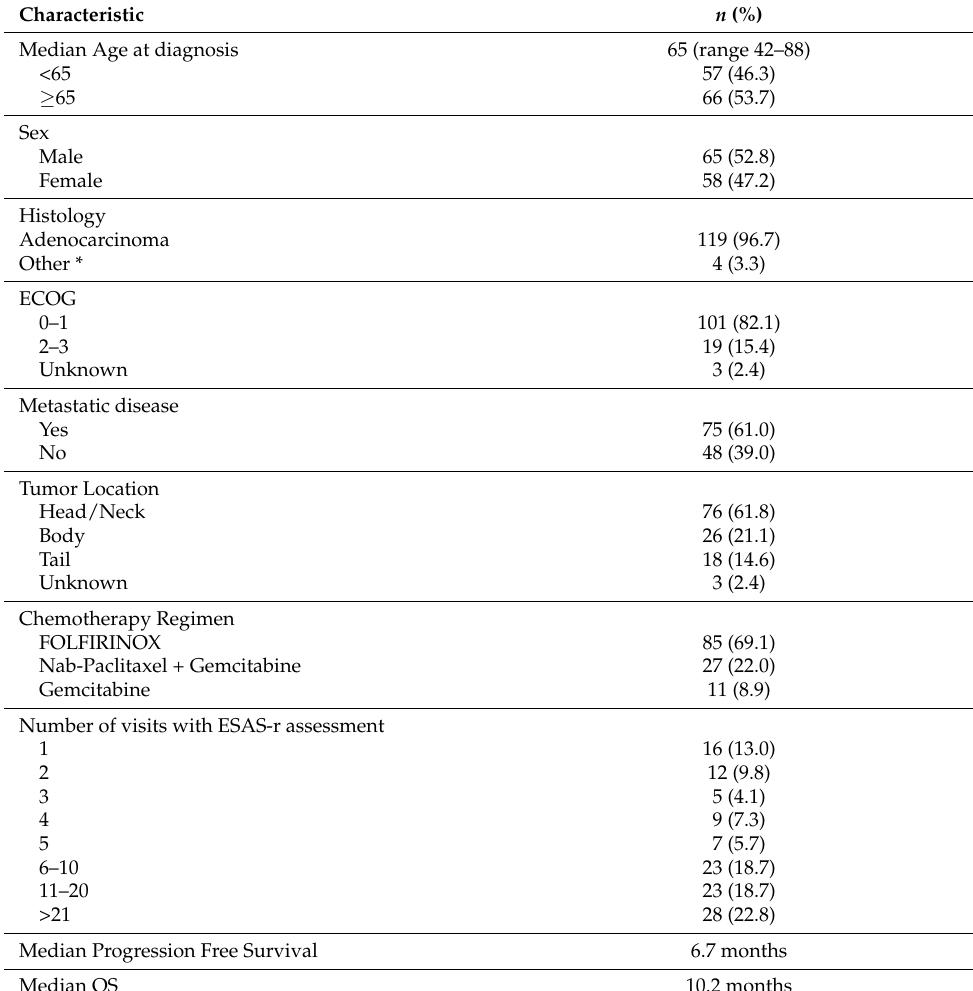
Table 1. Baseline characteristics of patients with APC who received chemotherapy ( n =